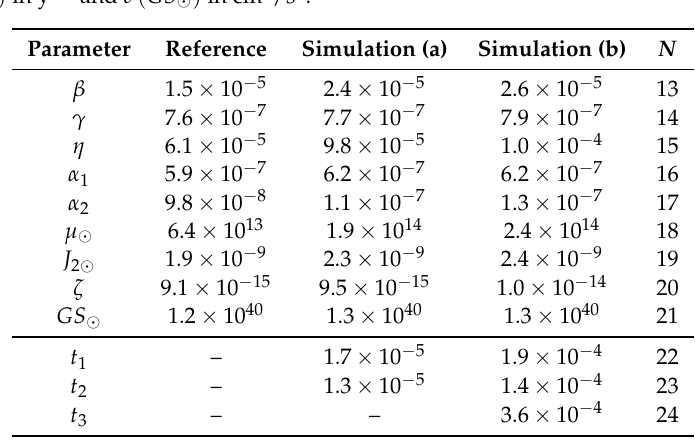
Table 4. Formal accuracies expected for the relativity parameters in the case of: reference simulation, simulation (a) and simulation (b), respectively. In the last column, we introduce a reference number, N , which labels each parameter, that will be adopted in Section 4.3. Note that σ ( µ (cid:12) ) is expressed in cm 3 /s 2 , σ ( ζ ) in y − 1 and σ ( GS (cid:12) ) in cm 3 /s 2